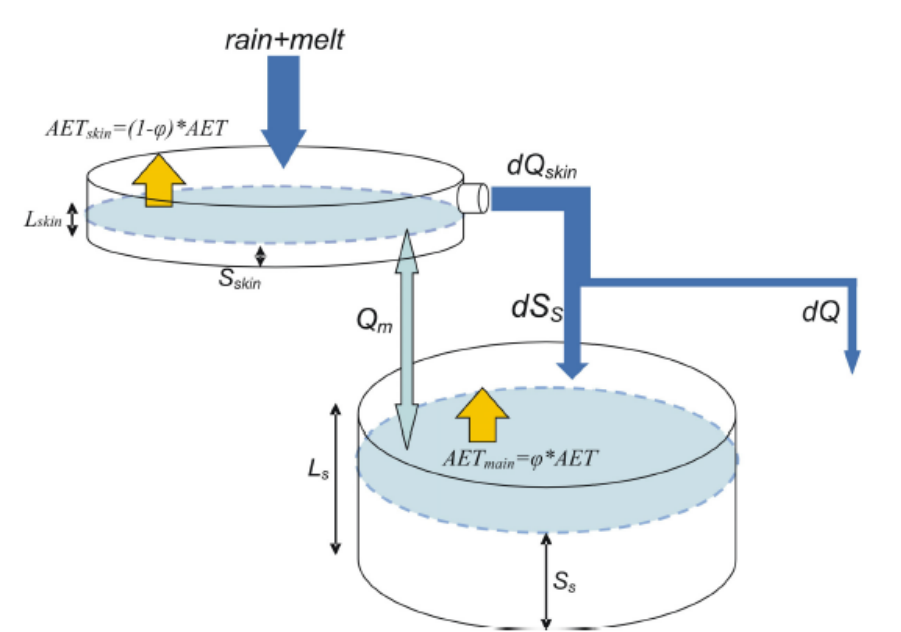
Figure 2. General schematic of the dual-layer soil moisture accounting scheme introduced in the TUW_dual model [25]. Reproduced with permission from [Juraj Parajka], [Matching ERS scatterome- ter based soil moisture patterns with simulations of a conceptual dual layer hydrologic model over Austria, Hydrol. Earth Syst. Sci., 13, 259–271, 2009]; published by [www.hydrol-earth-syst-sci.net/13/259/2009/, accessed on 24 November ], [2009]